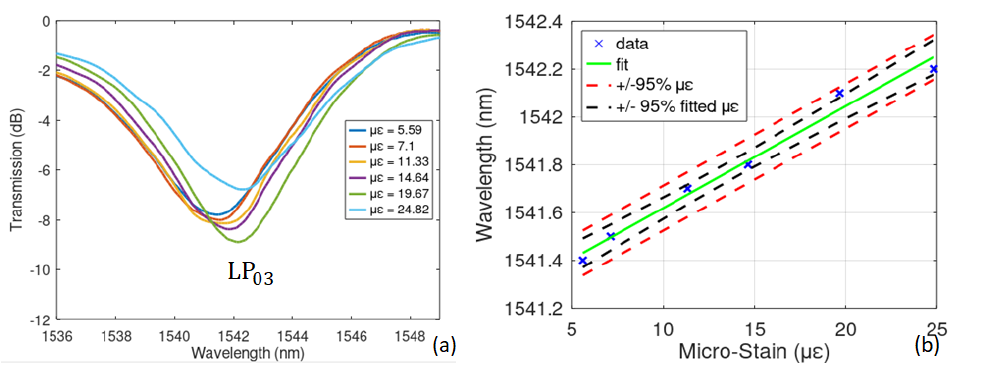
Figure 12. ( a ) Spectral response to a microstrain test. ( b ) The wavelength shift of the LP 03